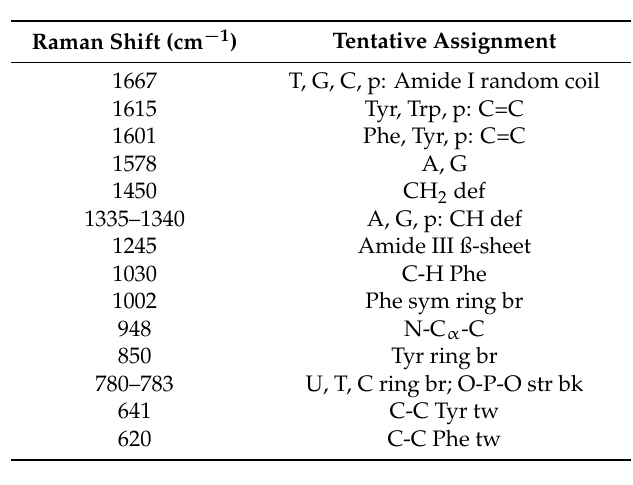
Table 2. Tentative Raman assignments. Abbreviations: (tw) twist, (U) uracil, (A) adenine, (G) guanine, (C) cytosine, (T) thymine, (br) breathing, (str) stretching, (bk) backbone, (sym) symmetric, (def) deformation, (p) protein.